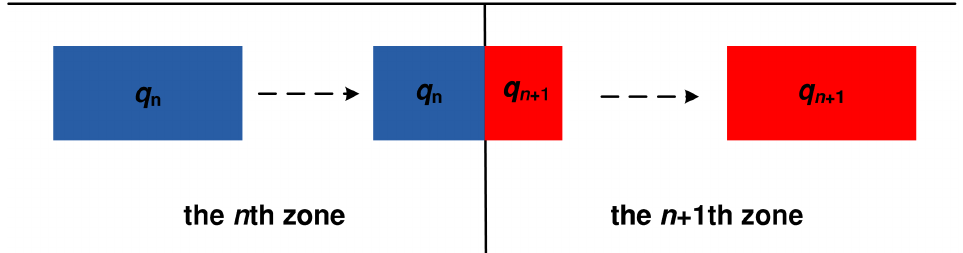
Figure 2. Loading process of the moving heat source on the PCB assembly.